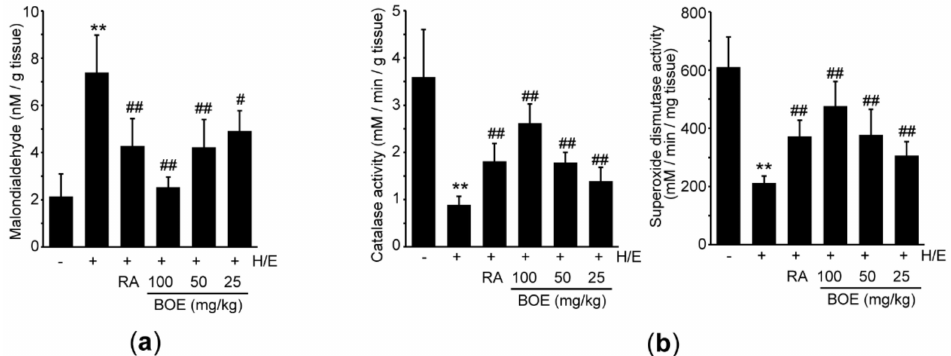
Figure 7. Effect of BOE on H/E-mediated oxidative stress in the gastric tissue. ( a ) The level of malondialdehyde in the gastric tissue was measured as a marker of lipid peroxidation. ( b ) Activities for catalase and superoxide dismutase were determined using hydrogen peroxide and nitroblue tetrazolium, respectively. All numerical results are presented as mean ± SD of ten mice (** p < 0.01 between the vehicle and H/E groups; ## p < 0.01, # p < 0.05 versus H/E-administered group). BOE, B. oleracea var. capitata L. extract; H/E, HCl/ethanol; RA, ranitidine